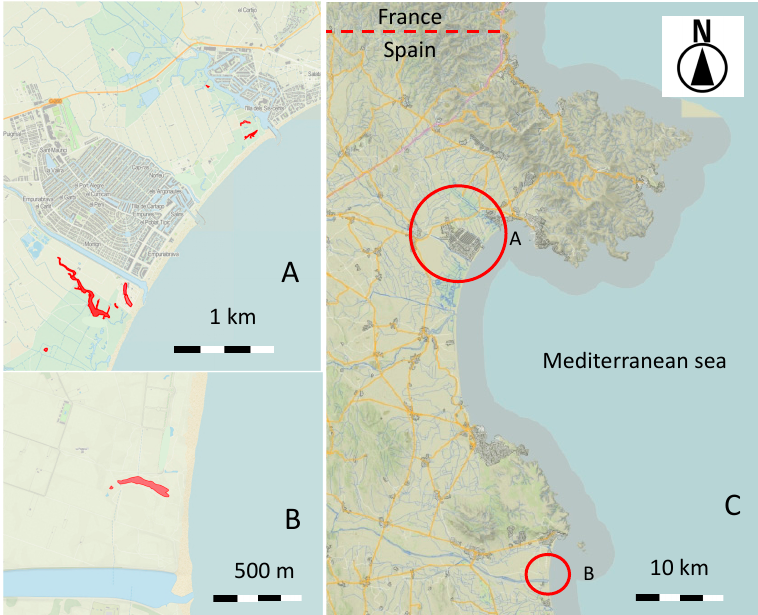
Figure 1. Location of the study region: Empordà coastal wetlands (Ter River Basin in the NE of the Iberian Peninsula) ( C ), with the detailed geographical position on the studied ponds in red ( A , B ). Eight of the studied ponds were located in the “Aiguamolls de l’Empord à ” Natural Park ( A ), and two were located south in the “El Montgr í , Illes Medes i el Baix Ter” Natural Park ( B ). This map was produced with the online software ArcGIS (version 10.5.1, 2017, ESRI Environmental System Research Institute, Redlands, CA, USA) (https: //